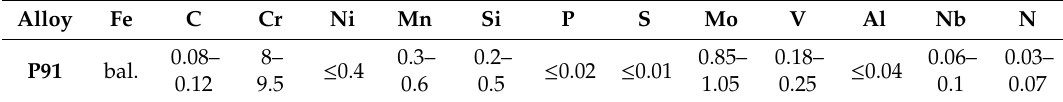
Table 1. Nominal composition (in wt.%) of the ferritic-martensitic steel, P91, used in this study [27].